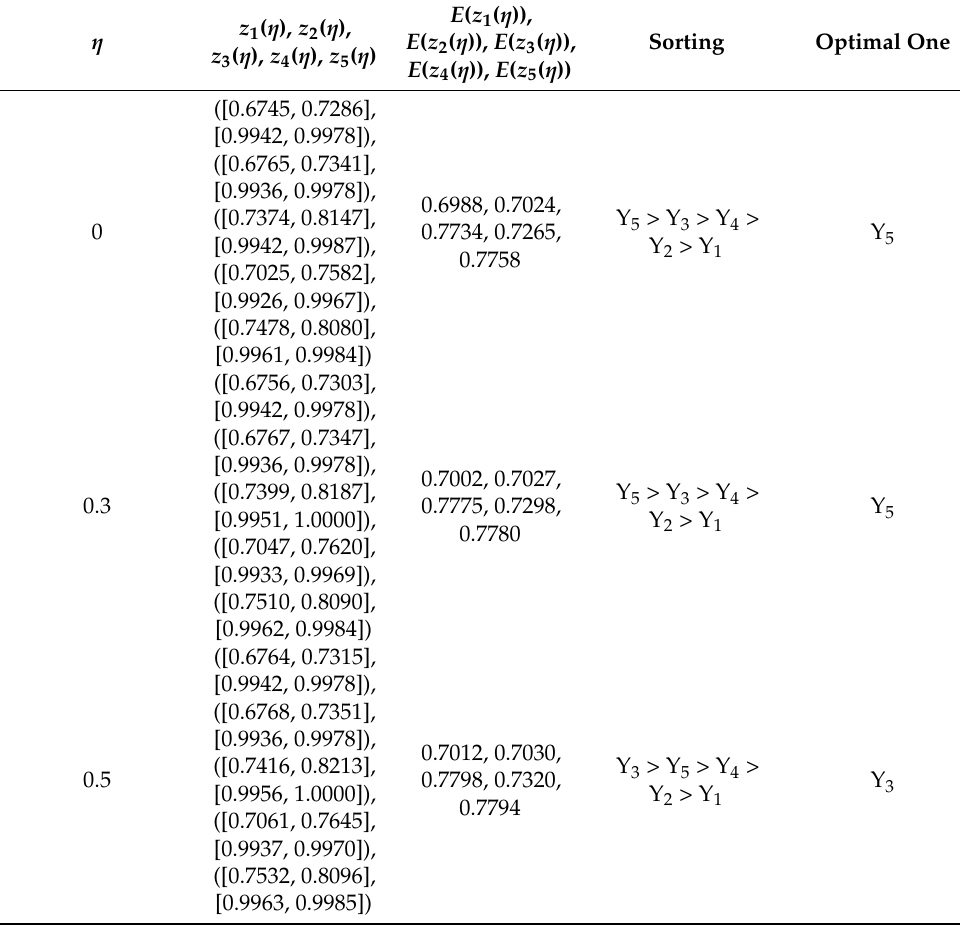
Table 2. Decision results of the proposed GDM method with various weight values of η